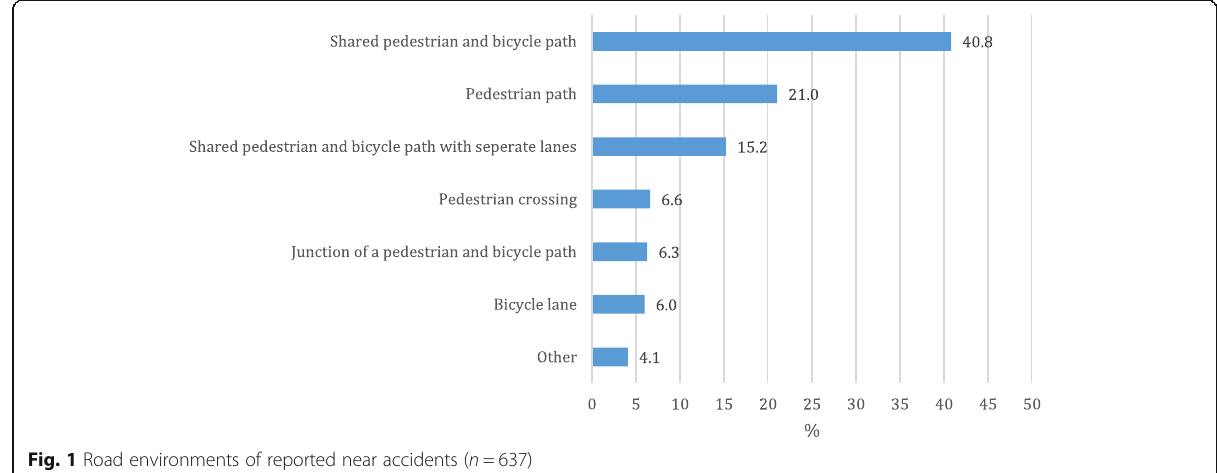
Fig. 1 Road environments of reported near accidents ( n = 637)